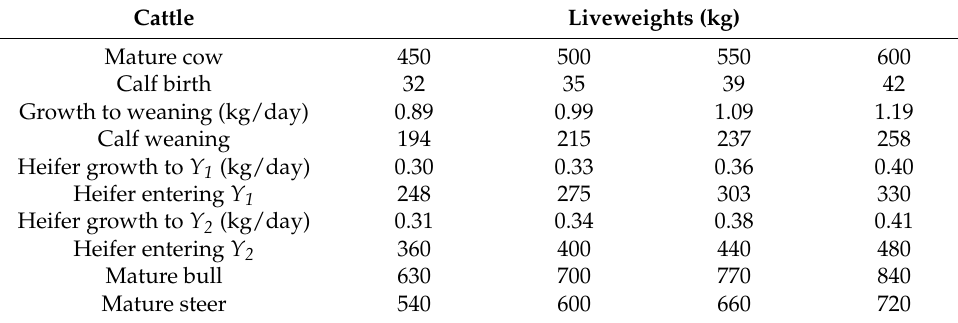
Table 1. Liveweights for cattle for scenario A with varying mature cow liveweight. Calf birth, weaning, heifer entering Y 1 , and heifer entering Y 2 weights were consistently 7%, 43%, 55%, and 80% of mature cow liveweight, respectively. Heifers were 12 months of age when entering Y 1 and 24 months of age when entering Y 2 .